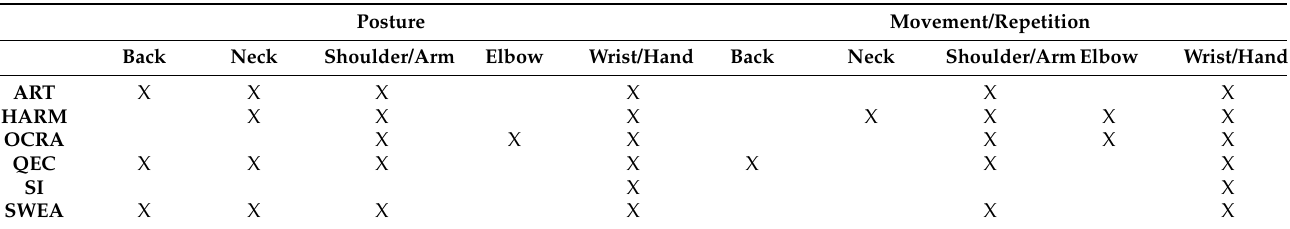
Table 2. Description of body regions where posture and movements/repetitions were assessed from the video and rated by the ergonomists, for each of the six